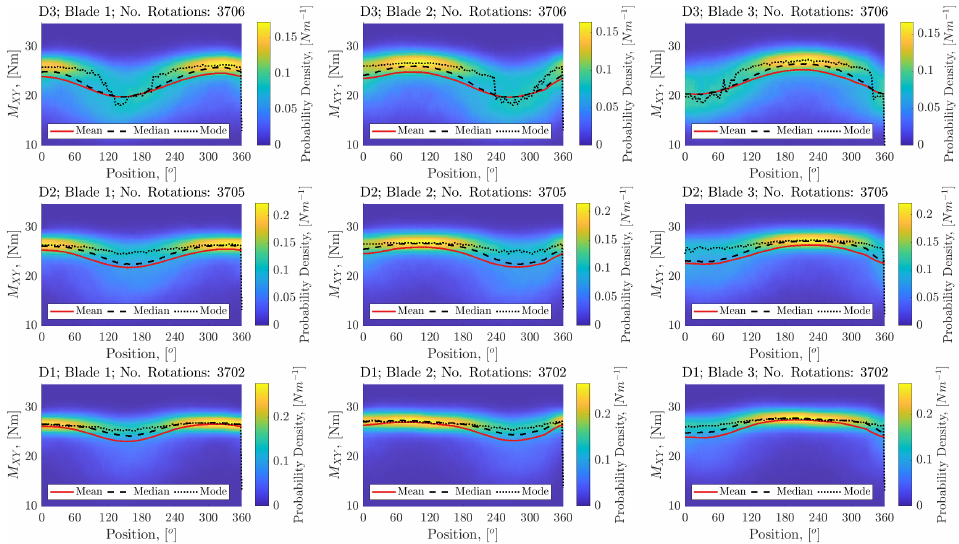
Figure 14. The probability density of M XY , as distributed with rotational position, with mean, median and mode averages overlaid for the CO cases. Position reference: 0 ◦ is the rotor position when blade 3 is at the top, dead centre or pointing upward toward the water’s